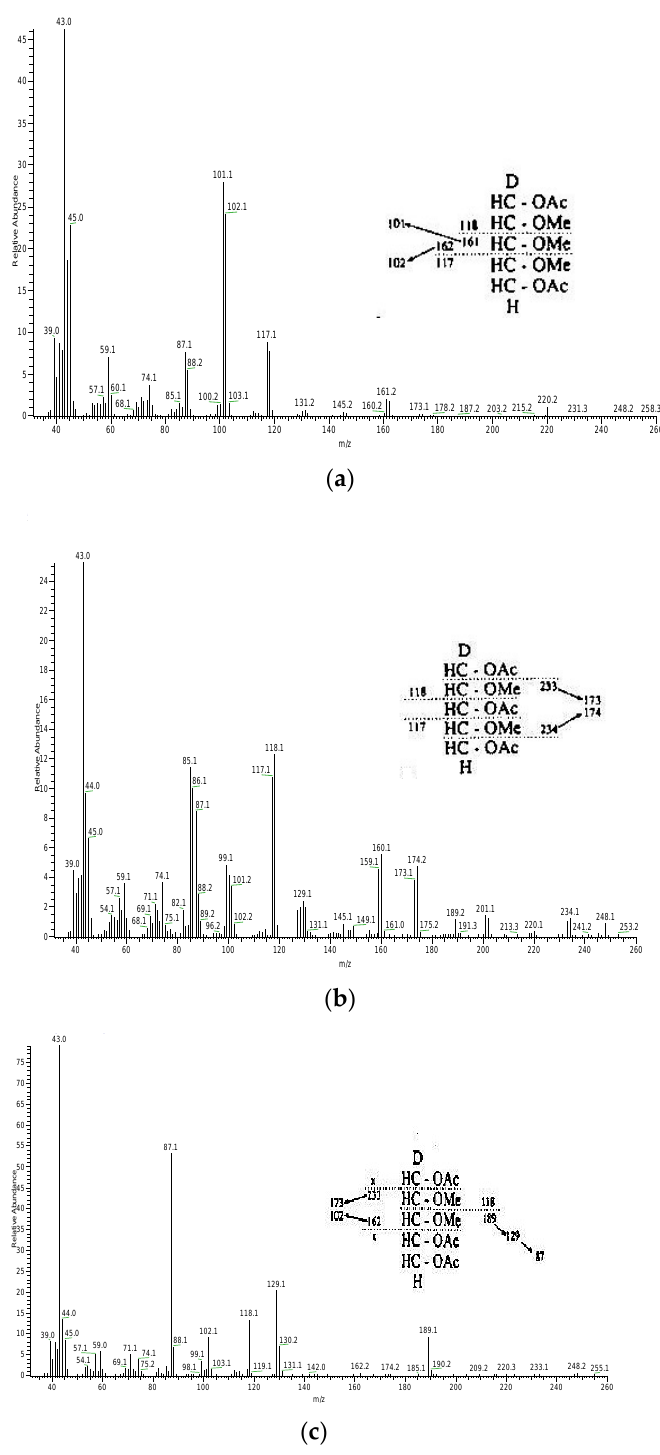
Figure 1. Mass spectrum of purified Yanang gum . ( a ) Terminal Xyl p ( b ) 1,3-Xyl p ( c ) 1,4-Xyl p. Table 1. Neutral sugar linkage composition (relative abundance %) of purified Yanang gum .